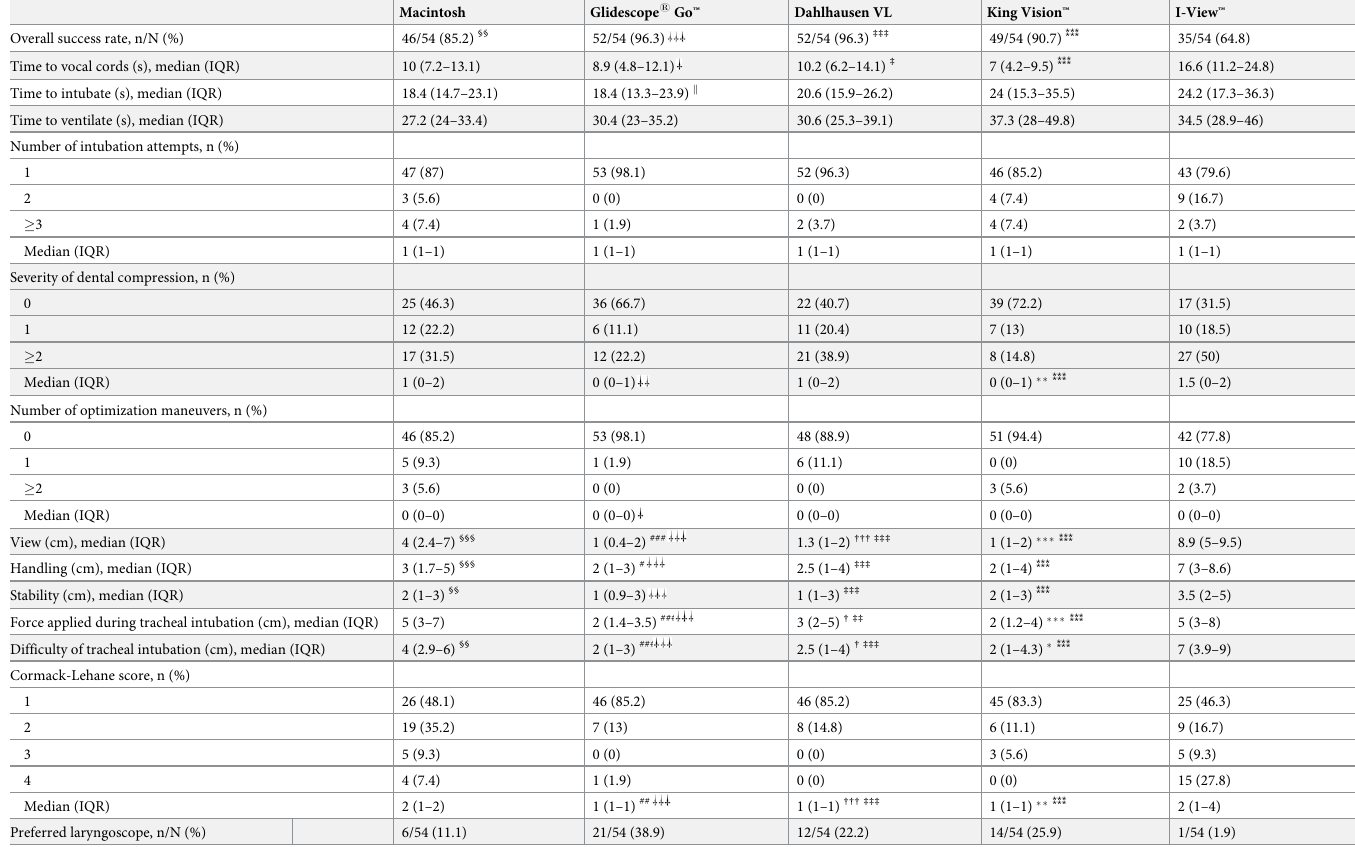
Table 3. Intubation data of paramedics with little previous experience in conventional and even less previous experience in video laryngoscopy.